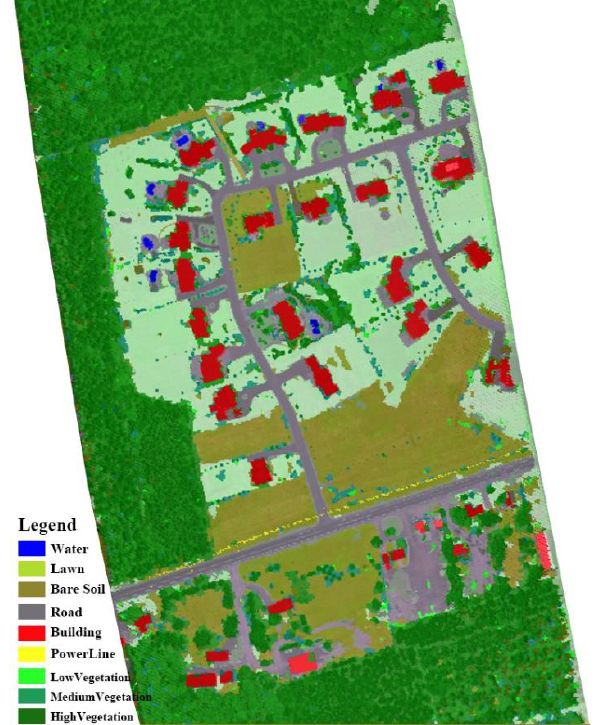
Figure 4. Classification results of nine classes in study area Object Classes